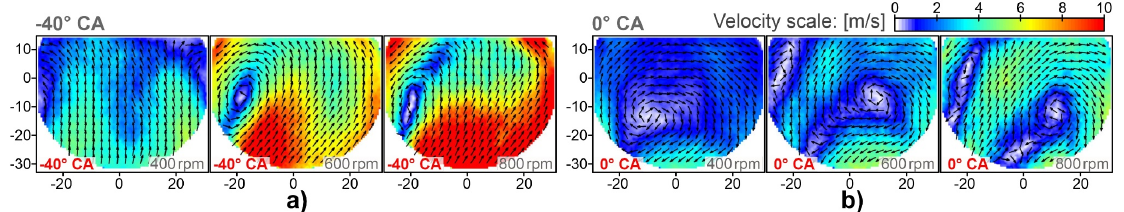
Figure 15. Ensemble averaged mean velocities (color: magnitude, arrows: flow direction) at 40° CA before TDC ( a ) and at TDC itself ( b ) for a variation of engine speeds (400 / 600 / 800 rpm). Peak compression pressure 100 bar in all cases.